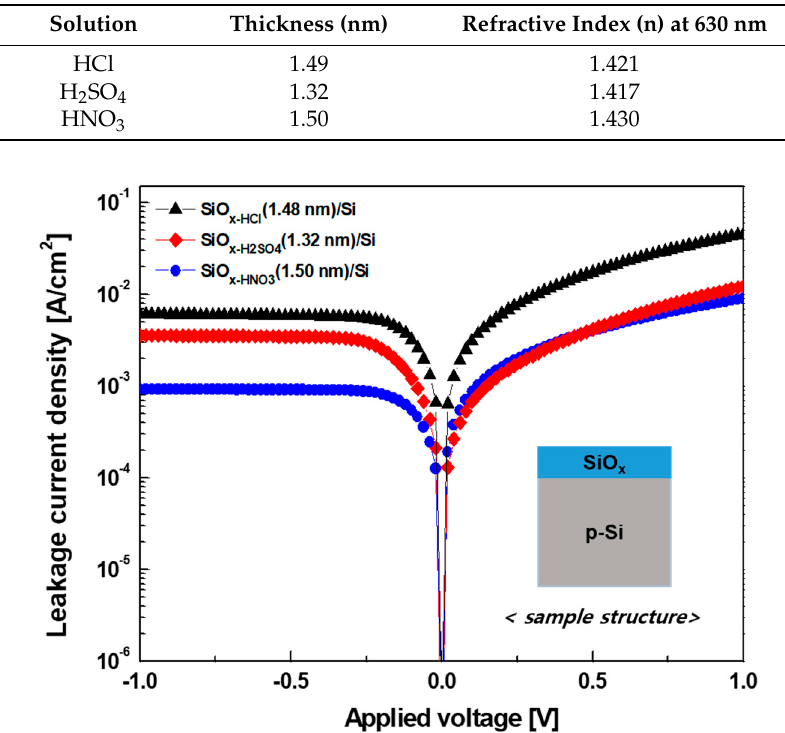
Figure 3. Current–voltage curves under dark condition for SiO x / Si formed in di ff erent acidic solutions. The SiO x thickness is 1.49 nm for SiO x-HCl , 1.32 nm for SiO x-H2SO4 , and 1.50 nm for SiO x-HNO3 , respectively.